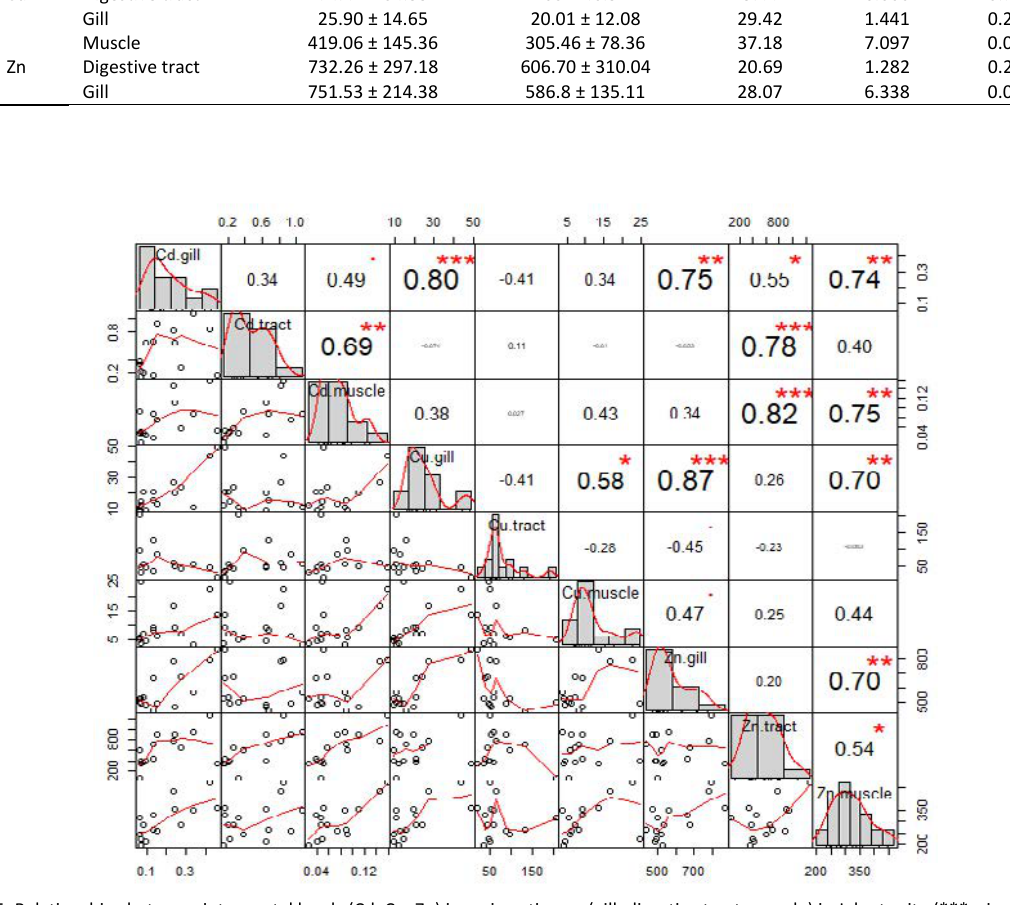
Fig. 5: Relationships between inter-metal levels (Cd, Cu, Zn) in various tissues (gill, digestive tract, muscle) in Jakarta site (***: significant at P < 0.05)